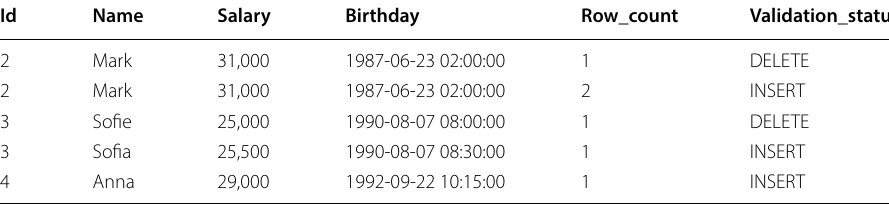
Table 4 Validation status for row delta table—“Users" table